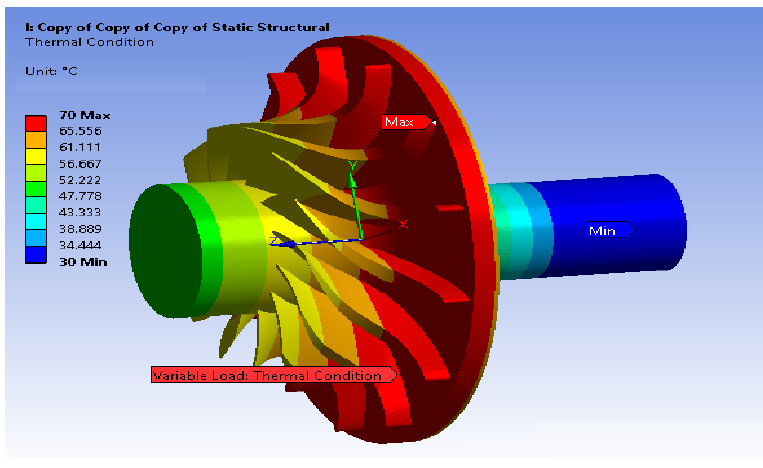
Figure 14. Thermal load distribution on the